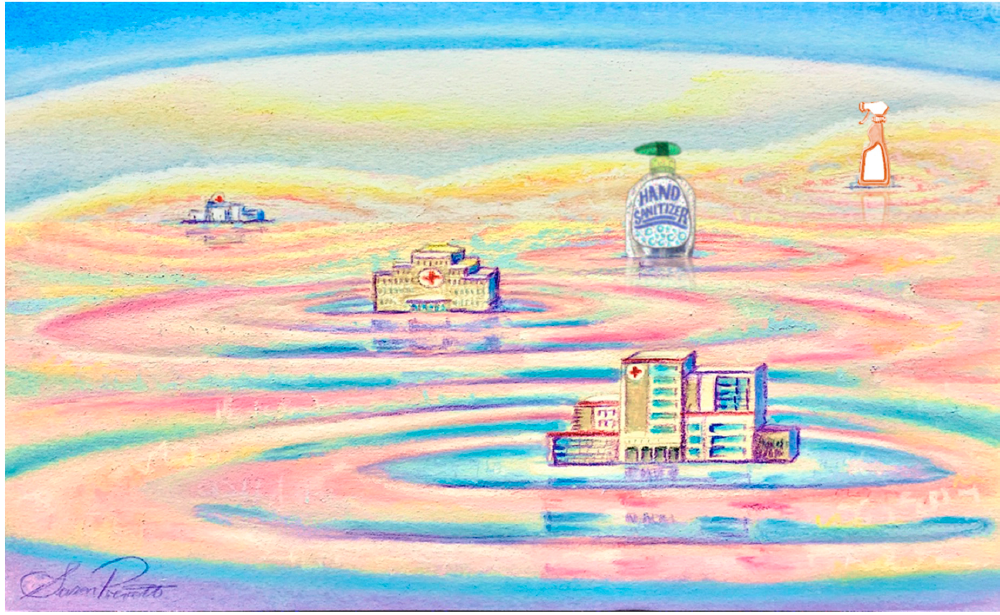
Figure 1. Ripple effect of the medicalization of childbirth and early infant care practices.